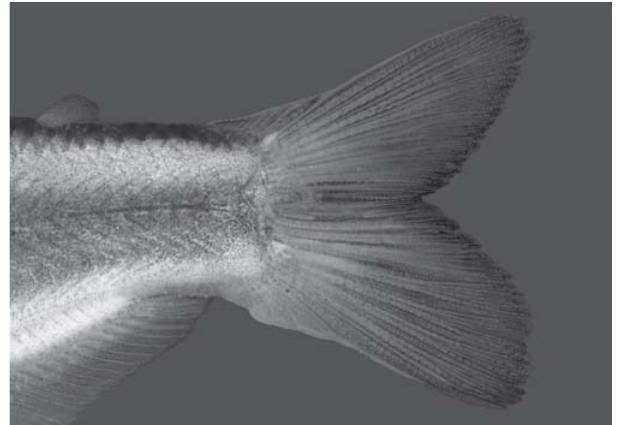
Fig. 13. Glandulocauda melanopleura , adult male, USNM 236415, SL 42.3 mm; caudal fin and caudal peduncle of adult male. Modified from Weitzman et al . (1988).